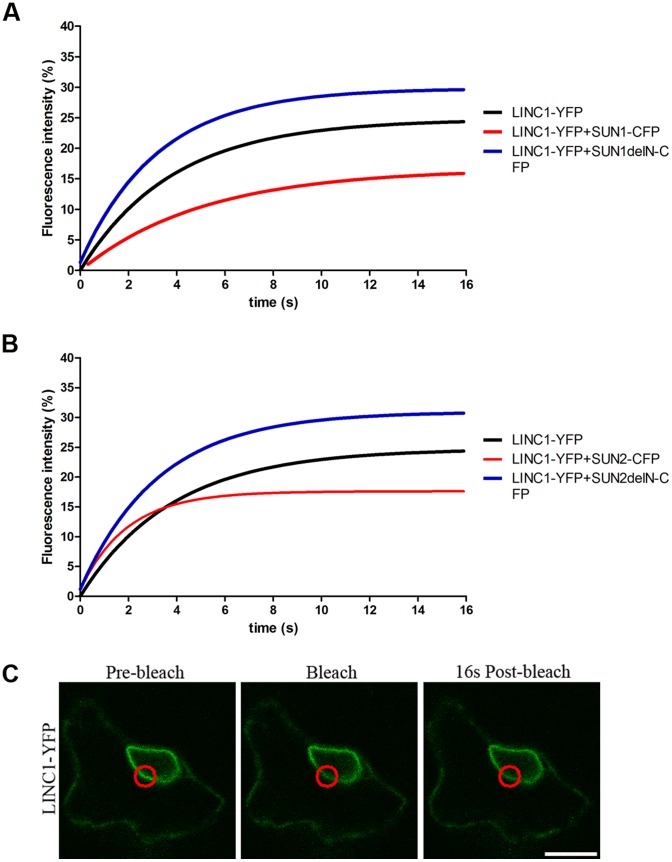
FRAP recovery master curves (relate to table 2); AtLINC1-YFP has a low recovery at the plant NE (black curves; A) AtLINC1-YFP mobility when co-expressed with AtSUN1 constructs; B) AtLINC1-YFP mobility when co-expressed with AtSUN2 constructs; full length AtSUN1-CFP/AtSUN2-CFP reduce the recovery of AtLINC1-YFP (red curves) but when the SUN N-terminus is deleted, AtLINC1-YFP recovery increases (blue curves); C) Representative image of FRAP experiment – LINC1-YFP fluorescence at the NE is bleached in ROI (red circle) and recovery monitored; size bar = 10μm.